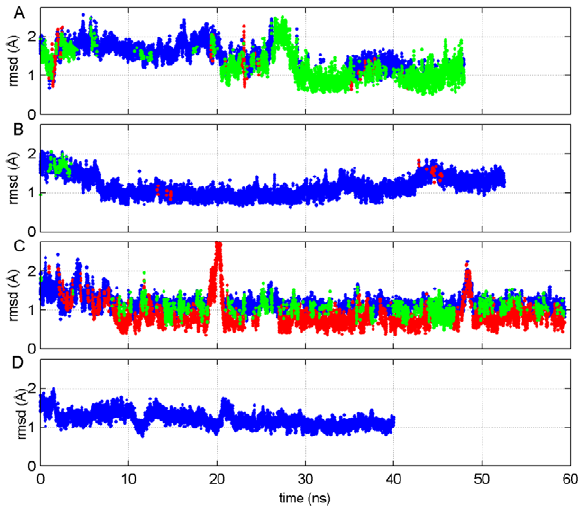
Figure 5. Combinatorial clustering of the KIX ensemble sampled in different simulations. The combinatorial clustering of all KIX conformations sampled in the KIX-only (A), KIX:MLL (B), c-Myb:KIX (C) and c-Myb:KIX:MLL (D) simulations. Blue, green and red dots represent the members in different clusters. The clustering observed in the figure points to the redistribution of the KIX populations upon c- Myb binding (C). This is because the frequency of occurrence of the KIX conformations is similar to those that KIX has when in the c- Myb:KIX:MLL case (blue dots). However, it decreases as compared to KIX (A), KIX:MLL (B) or the c-Myb:KIX:MLL (D)